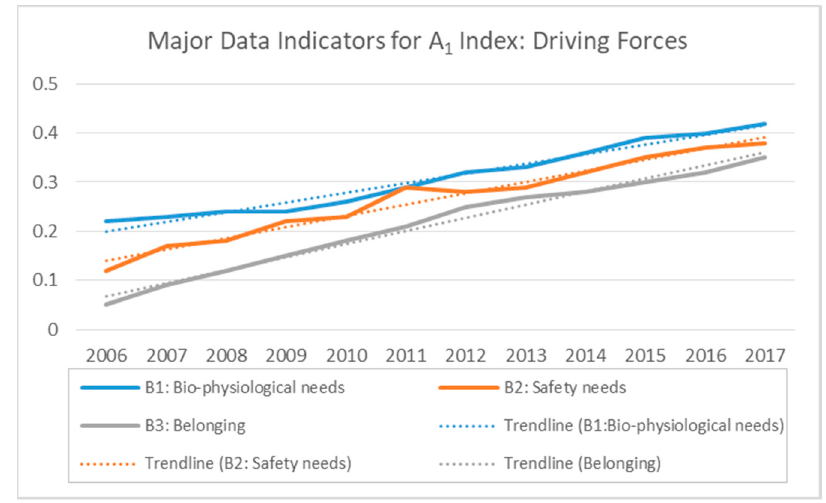
Figure 2. Major Data Indicators for A 1 Index: Driving Forces.